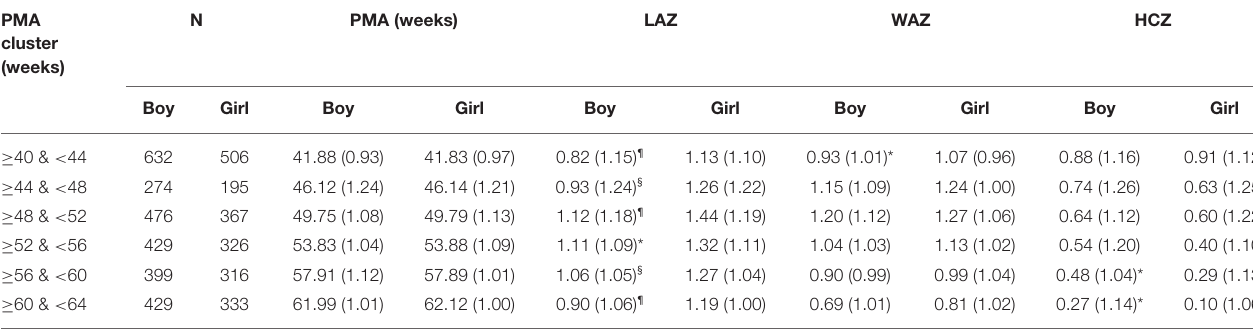
TABLE 2 | Z -scores of the preterm infants according to the IPPGS a . PMA